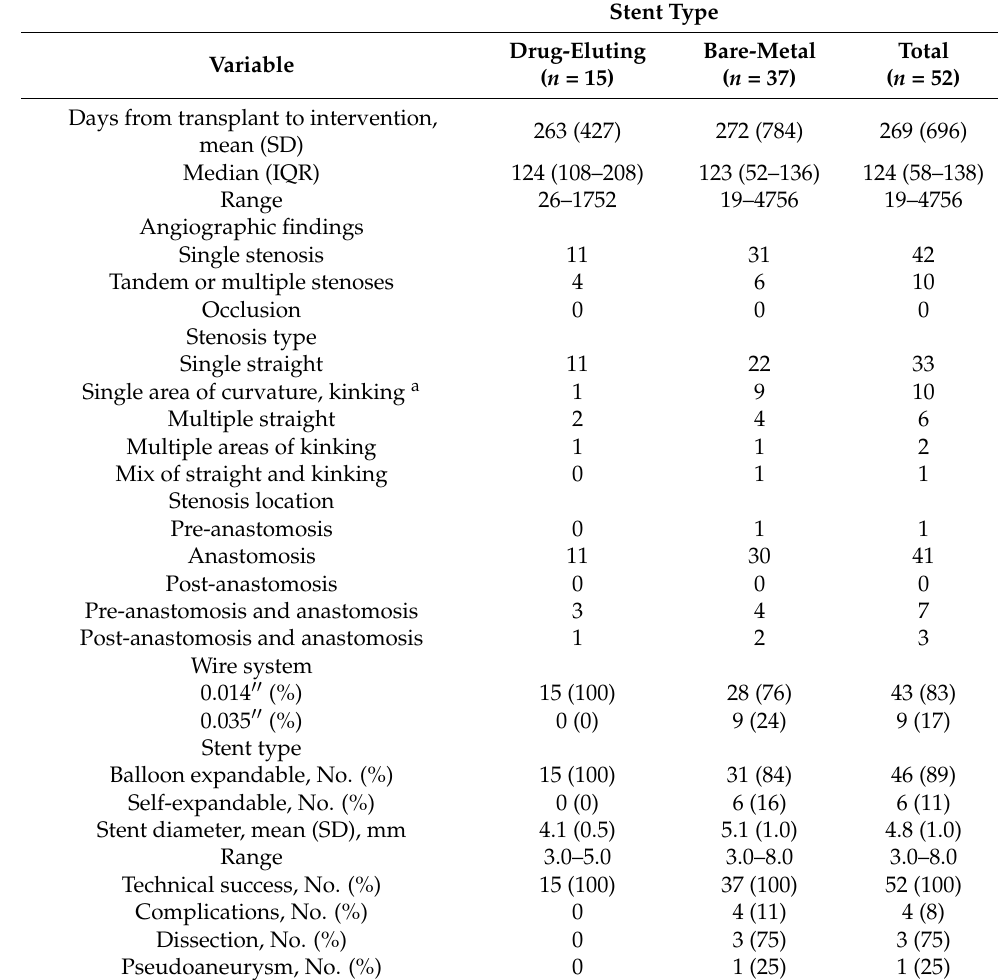
Table 2. Procedural details of stent